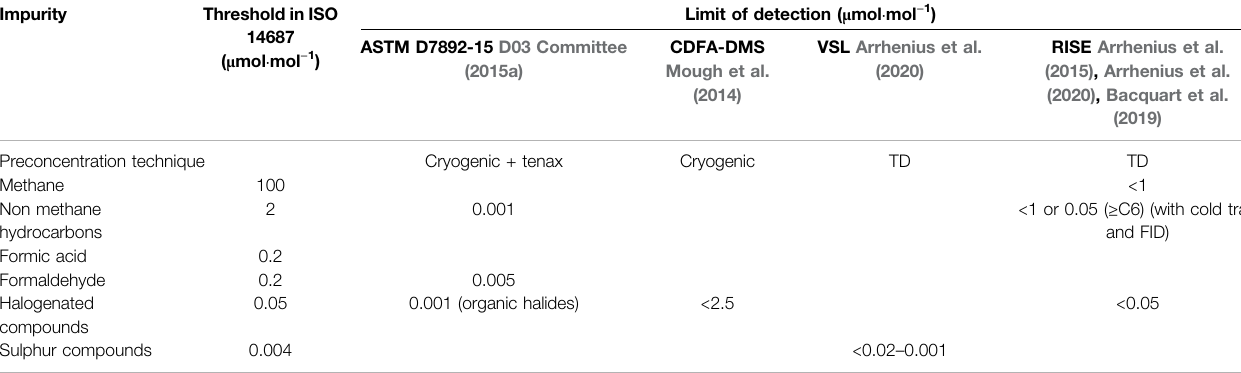
TABLE 2 | Detection limit per impurity and preconcentration technique with GC-MS for ASTM D7892-15, CDFA-DMS, VSL and RISE.